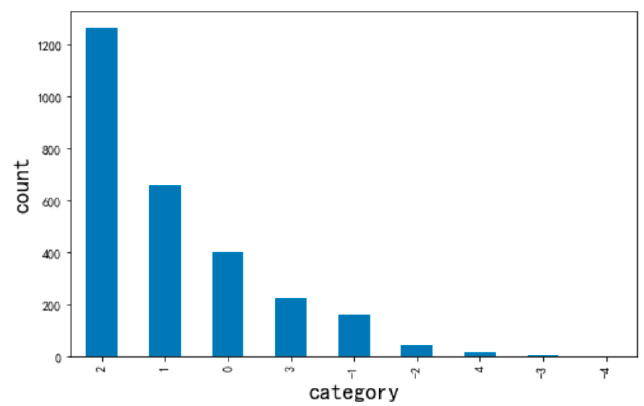
Figure 7. The sentiment distribution of the review text of Mutianyu Great Wall in Beijing, China. Appl. Sci. 2020 , 10 , x